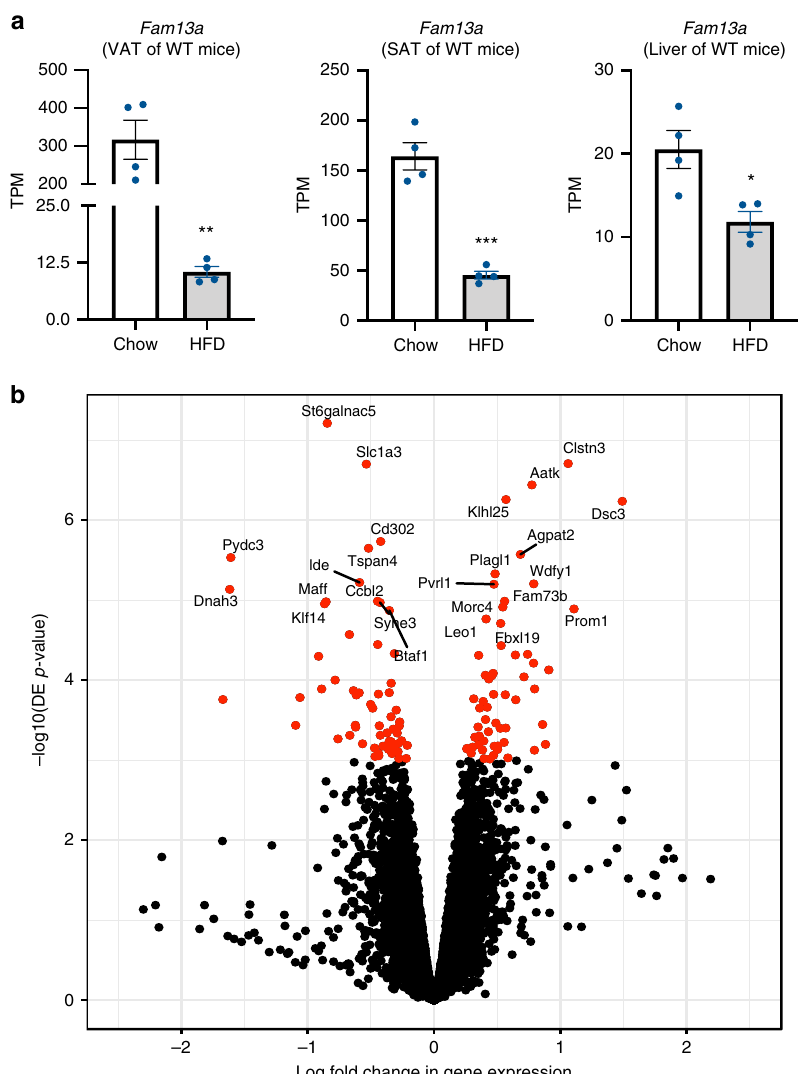
Fig. 6 Transcriptome pro fi ling of VAT and SAT in Fam13a KO and WT mice. a Fam13a transcript per million (TPM) in VAT, SAT, and liver of male WT mice on chow and HFD. b The volcano plot showing the differentially expressed (DE) genes in VAT and SAT male Fam13a KO on chow and HFD. n = 4 per group. Data are presented as mean ± SEM. * p < 0.05, ** p < 0.01, *** p < 0.001, unpaired t test. Source Data are provided as a Source Data fi